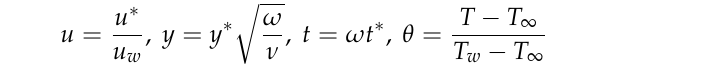
Figure 6. Contours of temperature profile. Example 3. Stokes Second Problem. In this problem, the sheet has behaved in the manner of a trigonometry function form. The governing equations, initial and boundary conditions are considered to be (40)– (43), except one boundary condition expressed as 𝑢 ∗ (𝑦 ∗ , 𝑡 ∗ ) = 𝑢 (cid:3050) 𝑐𝑜𝑠(𝜔𝑡 ∗ )